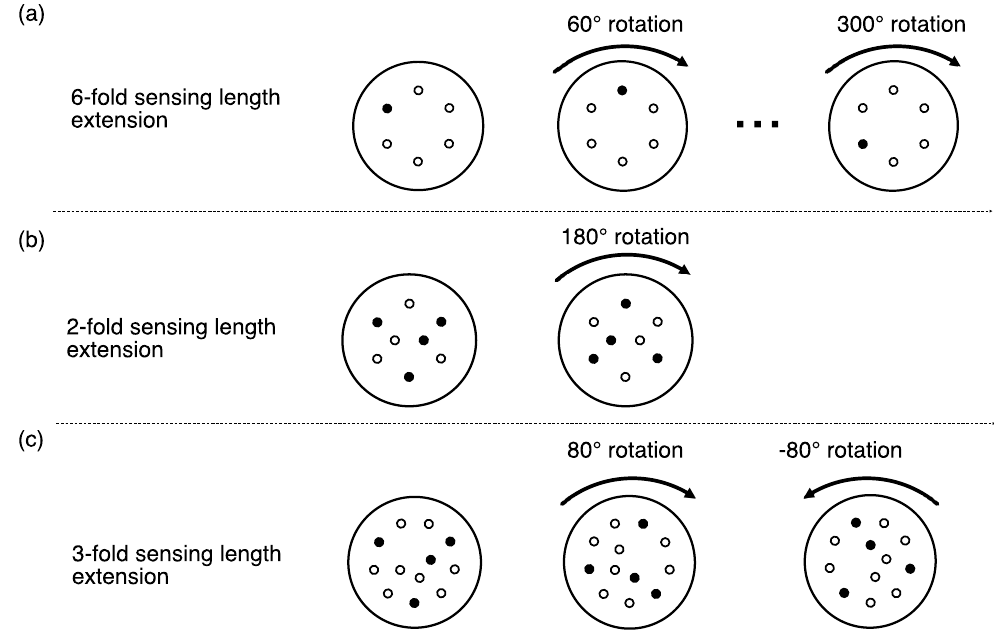
Figure 3. Fiber designs examples which can be used for a multicore fiber component. ( a ) Sixfold length extension optical fiber design with a single sensing core. ( b ) Two- and three-fold ( c ) length extension design for shape sensing fiber with four sensing cores.